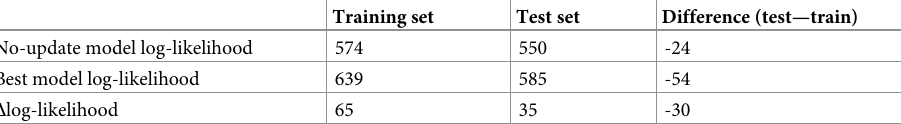
Table 1. Average log-likelihood, across participants and sessions, for the best model and the no-update model, evaluated on the training set as well as on the test set, and the difference between the test and training set log-like- lihood (right column). The bottom column shows the difference in log-likelihood between the best model and the no-update